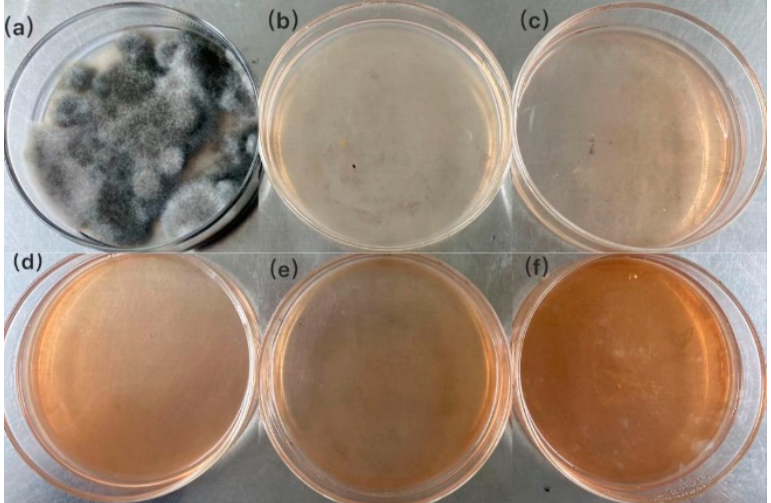
Figure 6. Colony formation of B. maydis on PDA plates. ( a – f ) different concentration (0, 20, 40, 60, 80, and 100 μ L ∙ mL − 1 , v / v ) of silver nanoparticles.